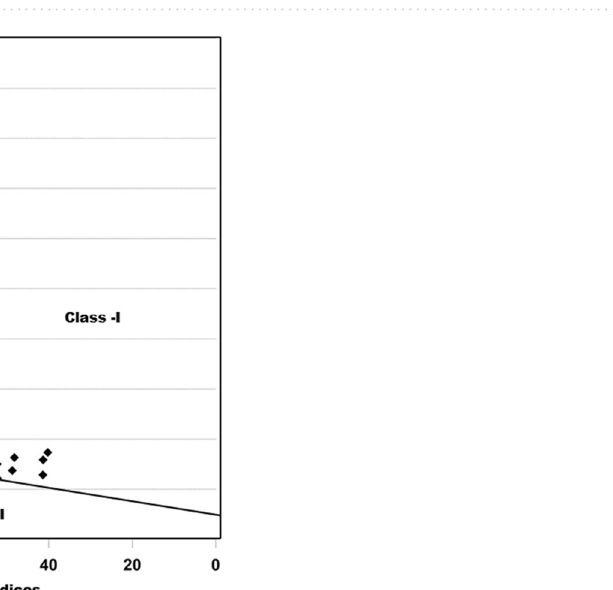
Figure 14. ( a ) Magnesium hazard and ( b ) Total hardness of the water samples collected from different locations of Tawang.